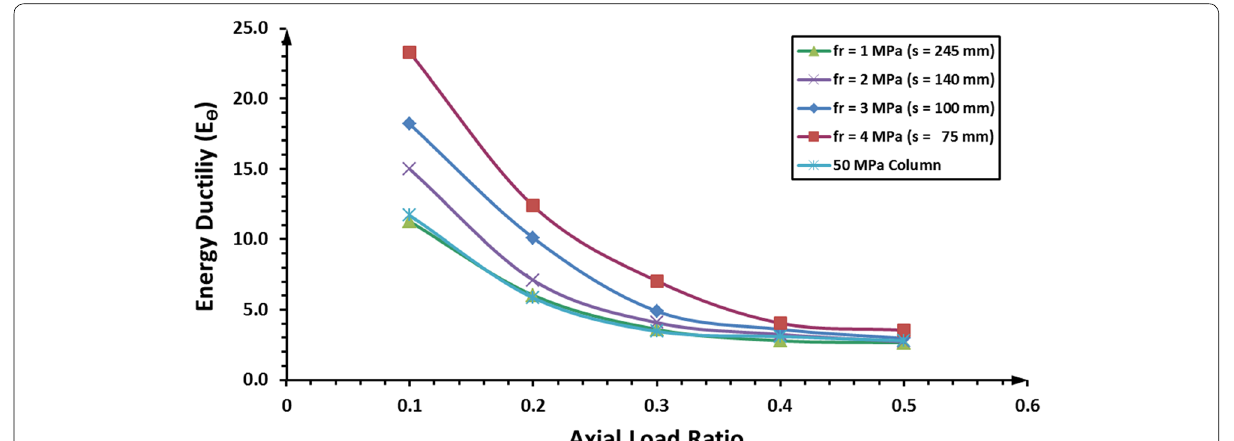
Fig. 6 Flexural rotation-based energy ductility index ( E θ ) ( ρ l